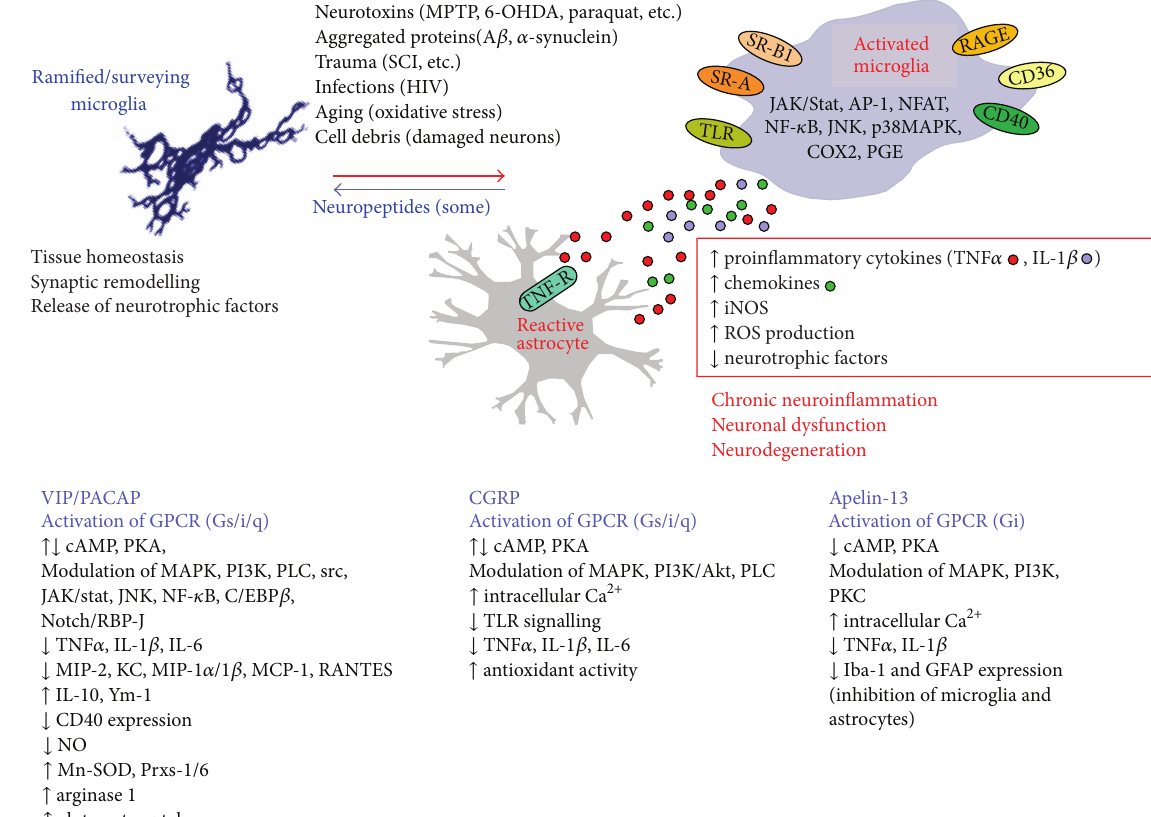
Figure 1: Schematic summary of microglia roles in physiological and pathological conditions in relation with the neuropeptide homeostatic influence on microglia. MPTP: 1-methyl-4-phenyl-1,2,3,6-tetrahydropyridine; 6-OHDA: 6-hydroxydopamine; A 𝛽 : beta-amyloid; SCI: spinal cord